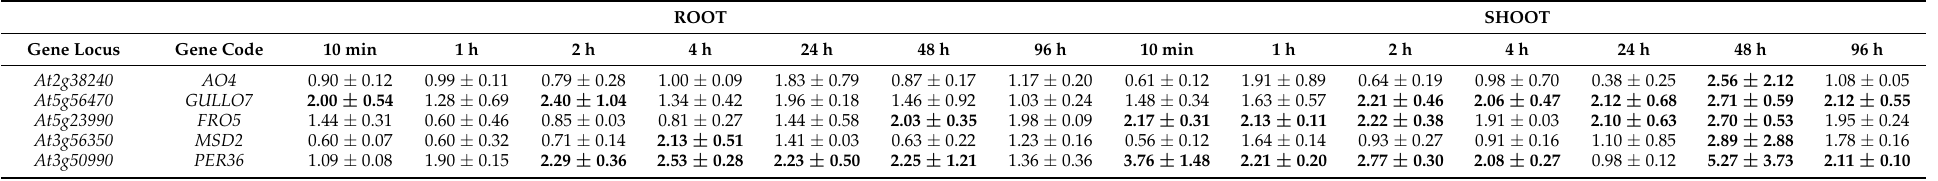
Table 4. Group D. Genes characterized by a strong upregulation in shoots at 48 h. Genes were selected based on a fold change ≥ 2 or ≤ 0.5 in at least one time point. Values are expressed as the mean and standard deviation ( ± ), values with a fold change ≥ 2 or ≤ 0.5 are indicated as boldfaced numbers. ROOT SHOOT